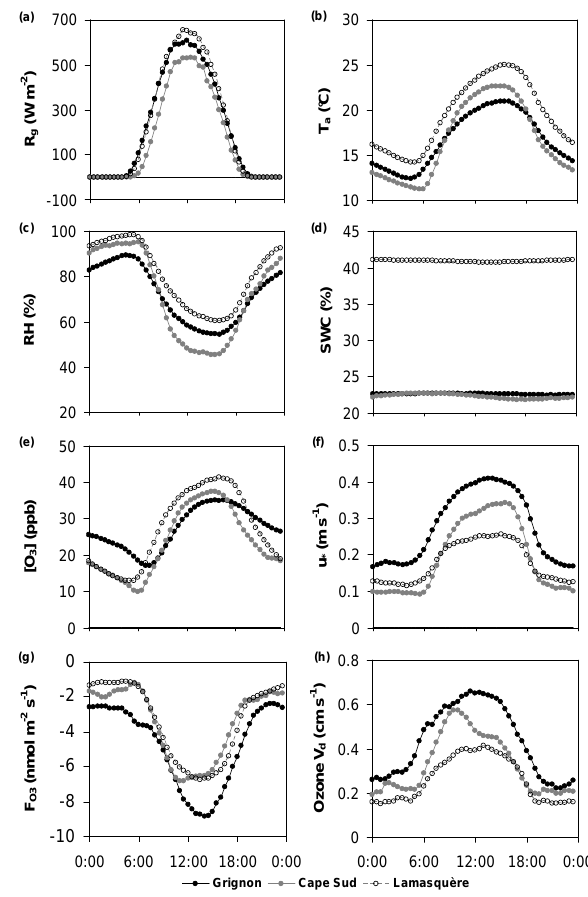
Figure 2: Half hourly arithmetic means of (a) global radiation, (b) air temperature, (c) air 30 Fig. 2. Half hourly arithmetic means of (a) global radiation, (b) air relative humidity, (d) soil water content, (e) O 3 concentration, (f) friction velocity, (g) O 3 flux, 31 temperature, (c) air relative humidity, (d) soil water content, (e) O 3 and (h) O 3 deposition velocity. Black, grey and open symbols are data from Grignon, La Cape 32 concentration, (f) friction velocity, (g) O 3 flux, and (h) O 3 deposi- Sud and Lamasquère respectively. 33 tion velocity. Black, grey and open symbols are data from Grignon, La Cape Sud and Lamasqu`ere